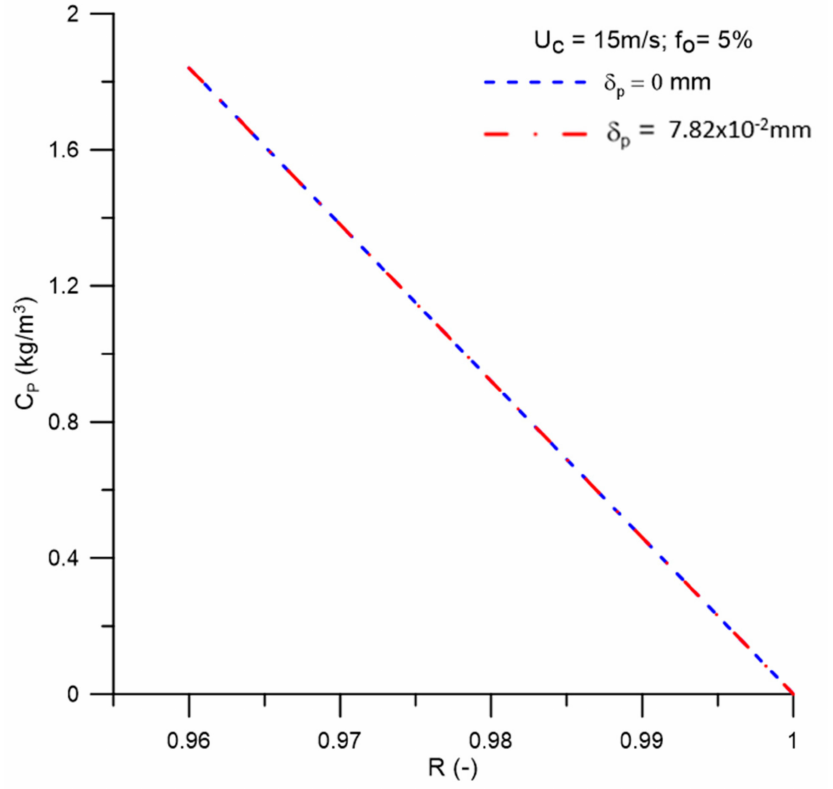
Figure 16. Oil concentration behavior in the permeate for different values of the membrane rejection